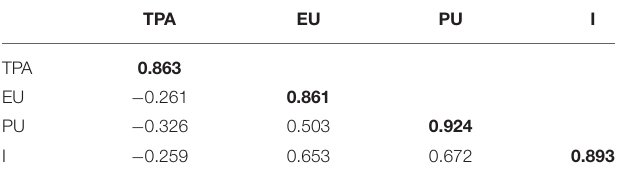
Bold diagonals represent square root of AVE.